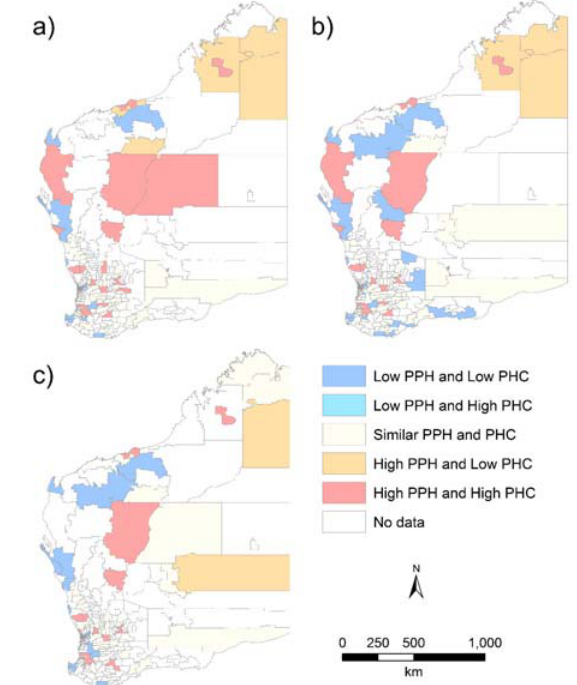
Figure 9. Relationship of PHC to PPH relative to State (a,b), ARIA-based regions (c,d) and Health Regions